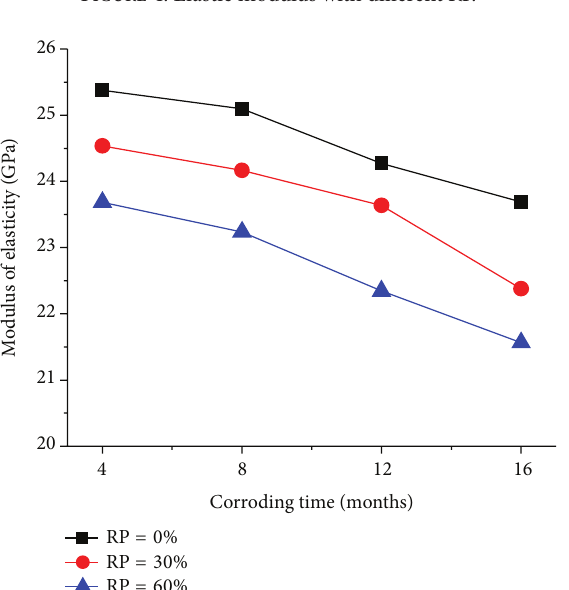
Figure 4: Elastic modulus with different RP.